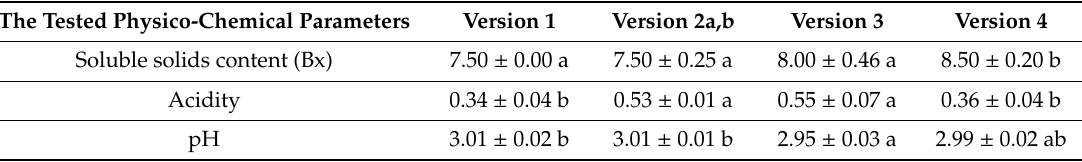
Table 3. The soluble solids content, pH, and acidity in the designed